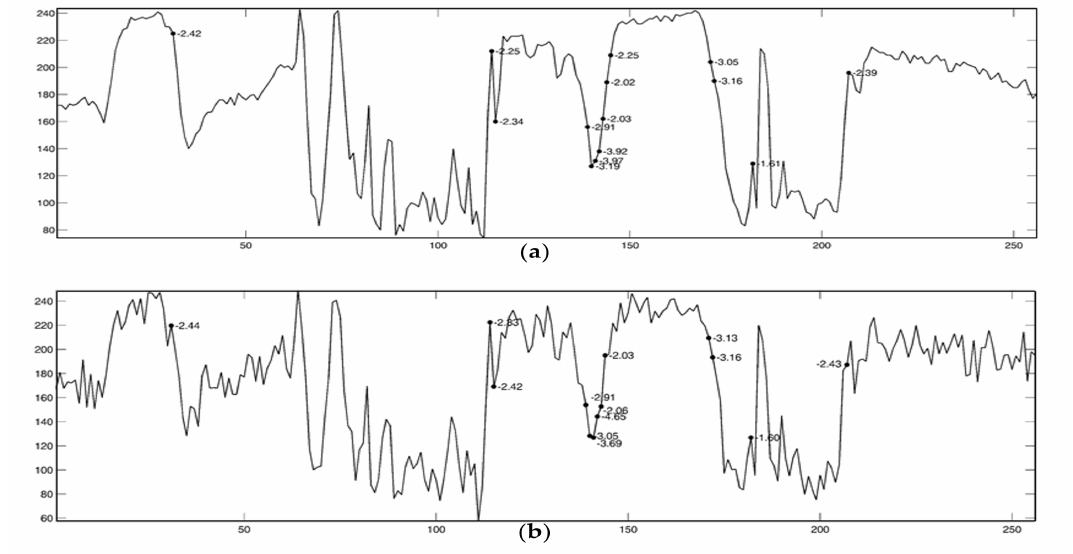
Figure 9. ( a ) Row No. 125 of image shown in Figure 2a, ( b ) Row No. 125 of the image with the addition if Gaussian noise (28 dB) modulus maxima are marked as a circle in both images, and the corresponding Lipschitz value is written in numerical